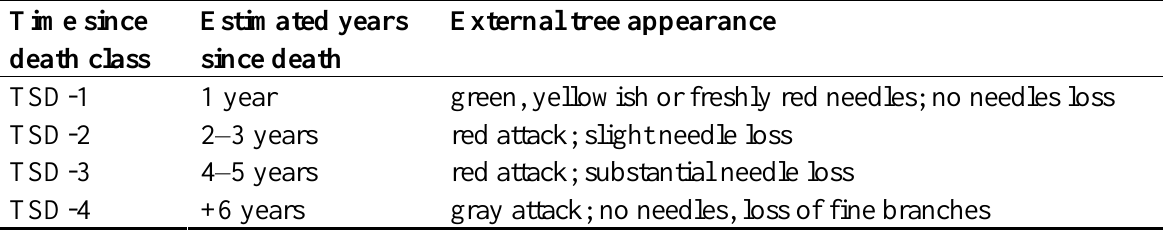
Table 2. Description of the time-since-death classes for beetle-killed lodgepole pine. Modified from Thrower et al. [19] and Lewis et al. [20].